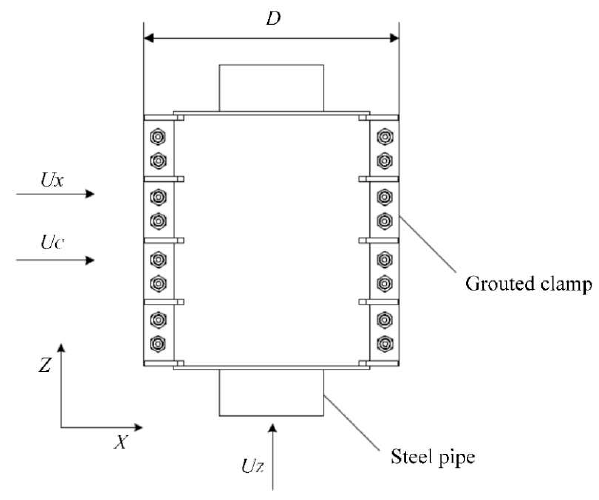
Figure 5. Stress diagram of vertical mounting clamp.